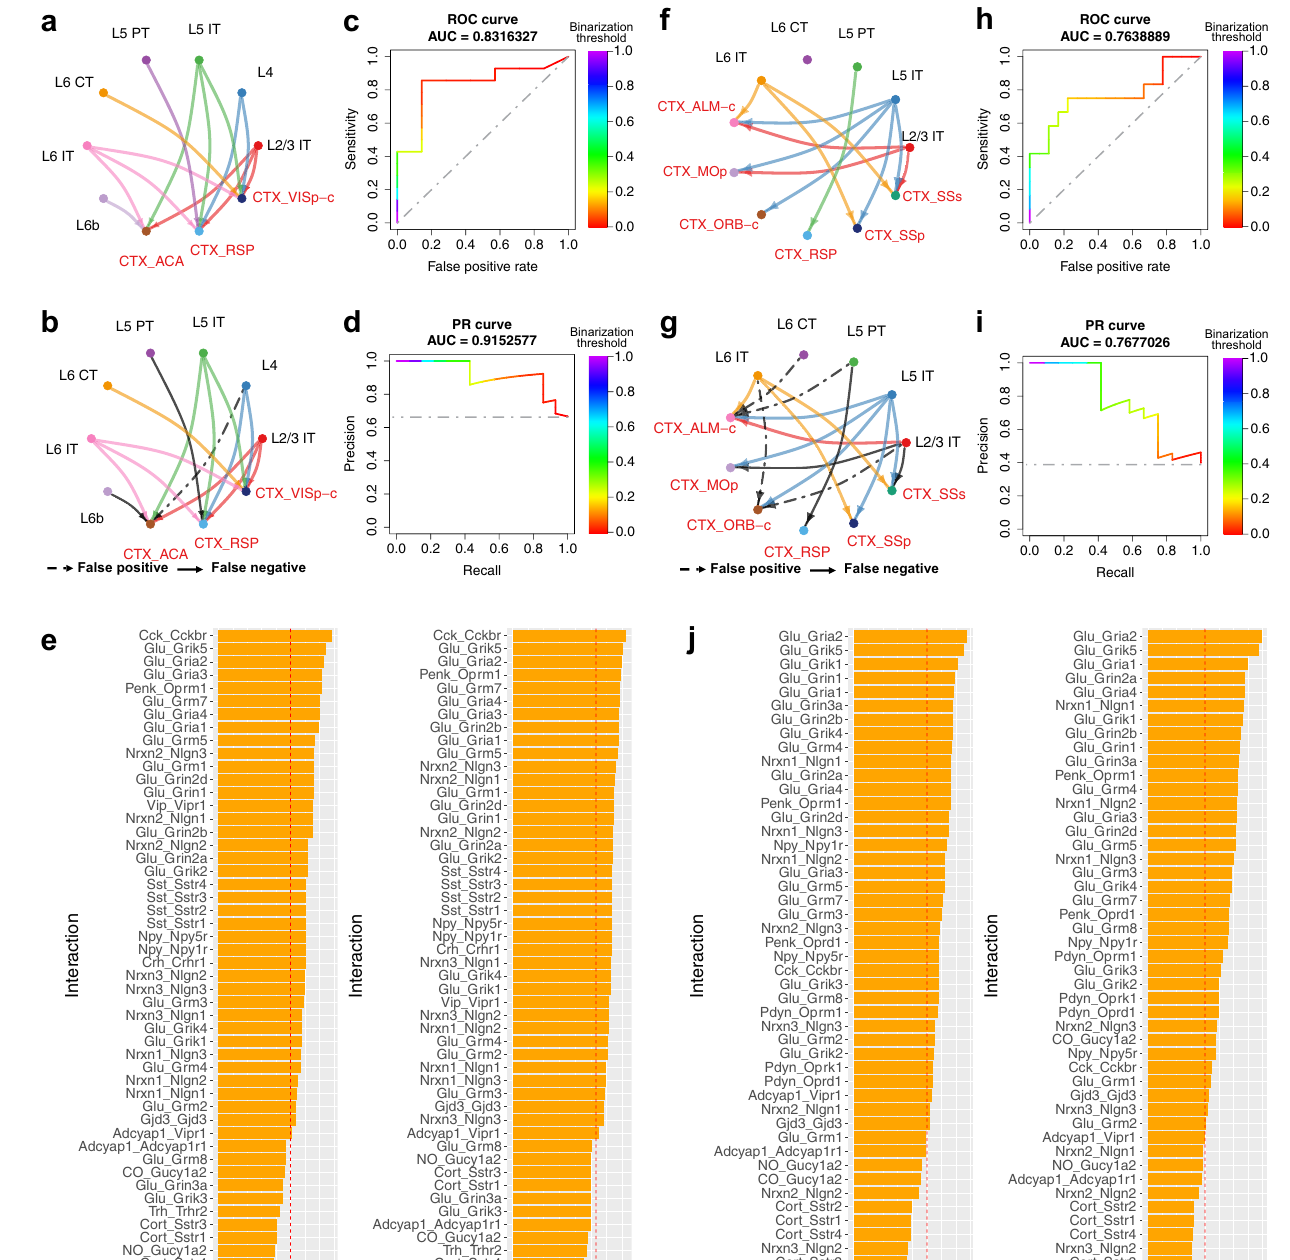
Fig. 2 | Benchmarking NeuronChat on projection networks of two mouse cor- tex regions: VISp and ALM. a Projections from seven cell types of VISp to their cortical target regions, identi fi ed by retrograde labeling 3 . b Aggregated and binarized intercellular communication network for VISp. The false-positive links representthosepredictedbyNeuronChatbutnotidenti fi edbyretrogradelabeling. The false-negative links are those identi fi ed by retrograde labeling but missed by NeuronChat prediction. Threshold for binarization is 0.028 (normalized by the maximum) in this plot. c ROC curve for the NeuonChat-inferred aggregated intercellular communication network for VISp, with AUROC indicated on the top.